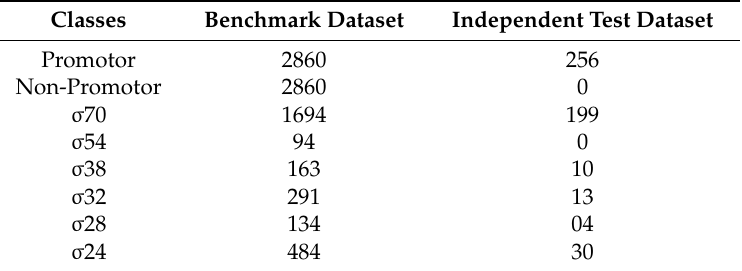
Table 1. Sigma classes and sample